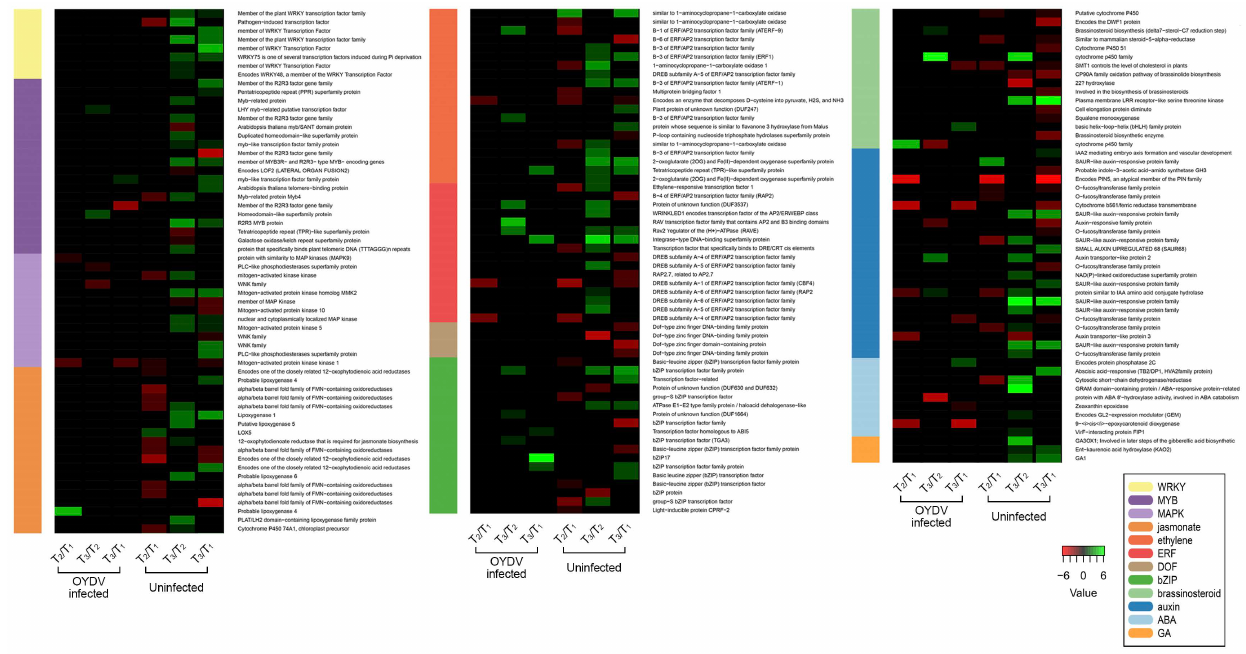
Figure 2. Heatmap developed using DEGs isolated in uninfected bulbs in the three comparisons T 2 /T 1 , T 3 /T 2 , and T 3 /T 1 . Log2 FC for uninfected and OYDV-infected conditions is displayed. DEGs for each class were listed in Table